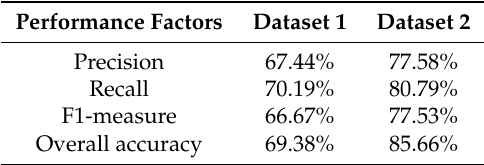
Table 6. Tabulation of precision, recall, f1-measure, and accuracy of each